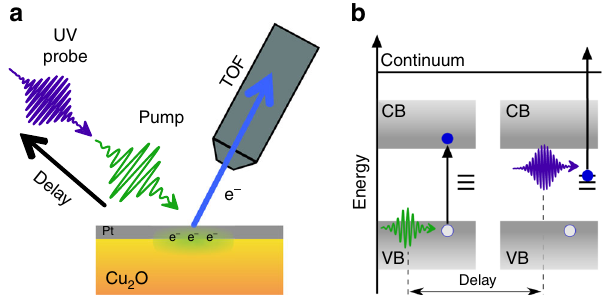
Fig. 1 tr-2PPE working principle. a Schematic illustration of time-resolved two-photon photoemission spectroscopy (tr-2PPE) applied to Cu 2 O utilizing a time-of- fl ight (TOF) spectrometer. b The transient PES study was performed with a pump laser intensity of 24 µ J/cm 2 at 494 nm wavelength (~2.5 eV energy), giving rise to resonant excitation above the bandgap. The electron population distribution among the transient states was probed by a 274 nm laser pulse (~4.5 eV energy) and was recorded as a function of pump – probe